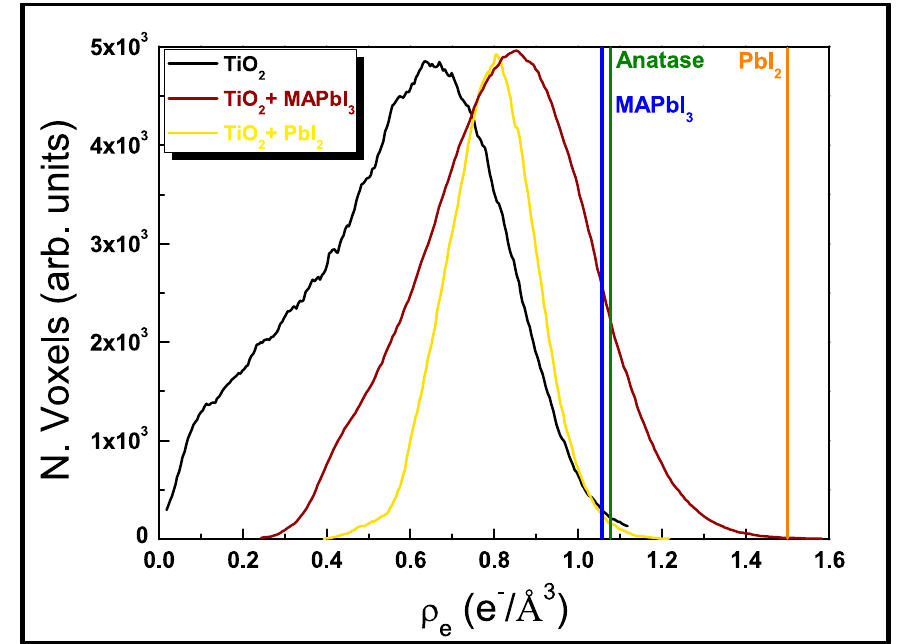
Figure 5. Electronic density distribution measured by CXDI in pure gig-lox TiO 2 , in the TiO 2 –MAPbI 3 blend and in the TiO 2 –PbI 2 blend.